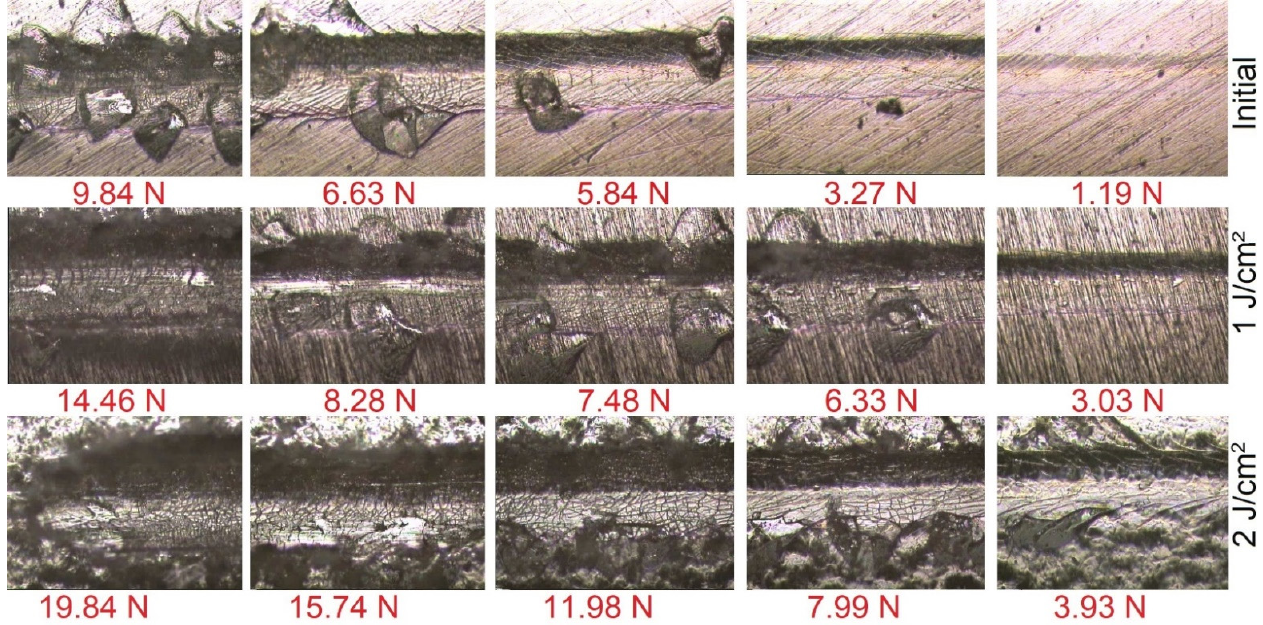
Figure 8. T he sample surfaces after the scratch tests under different indenter forces.